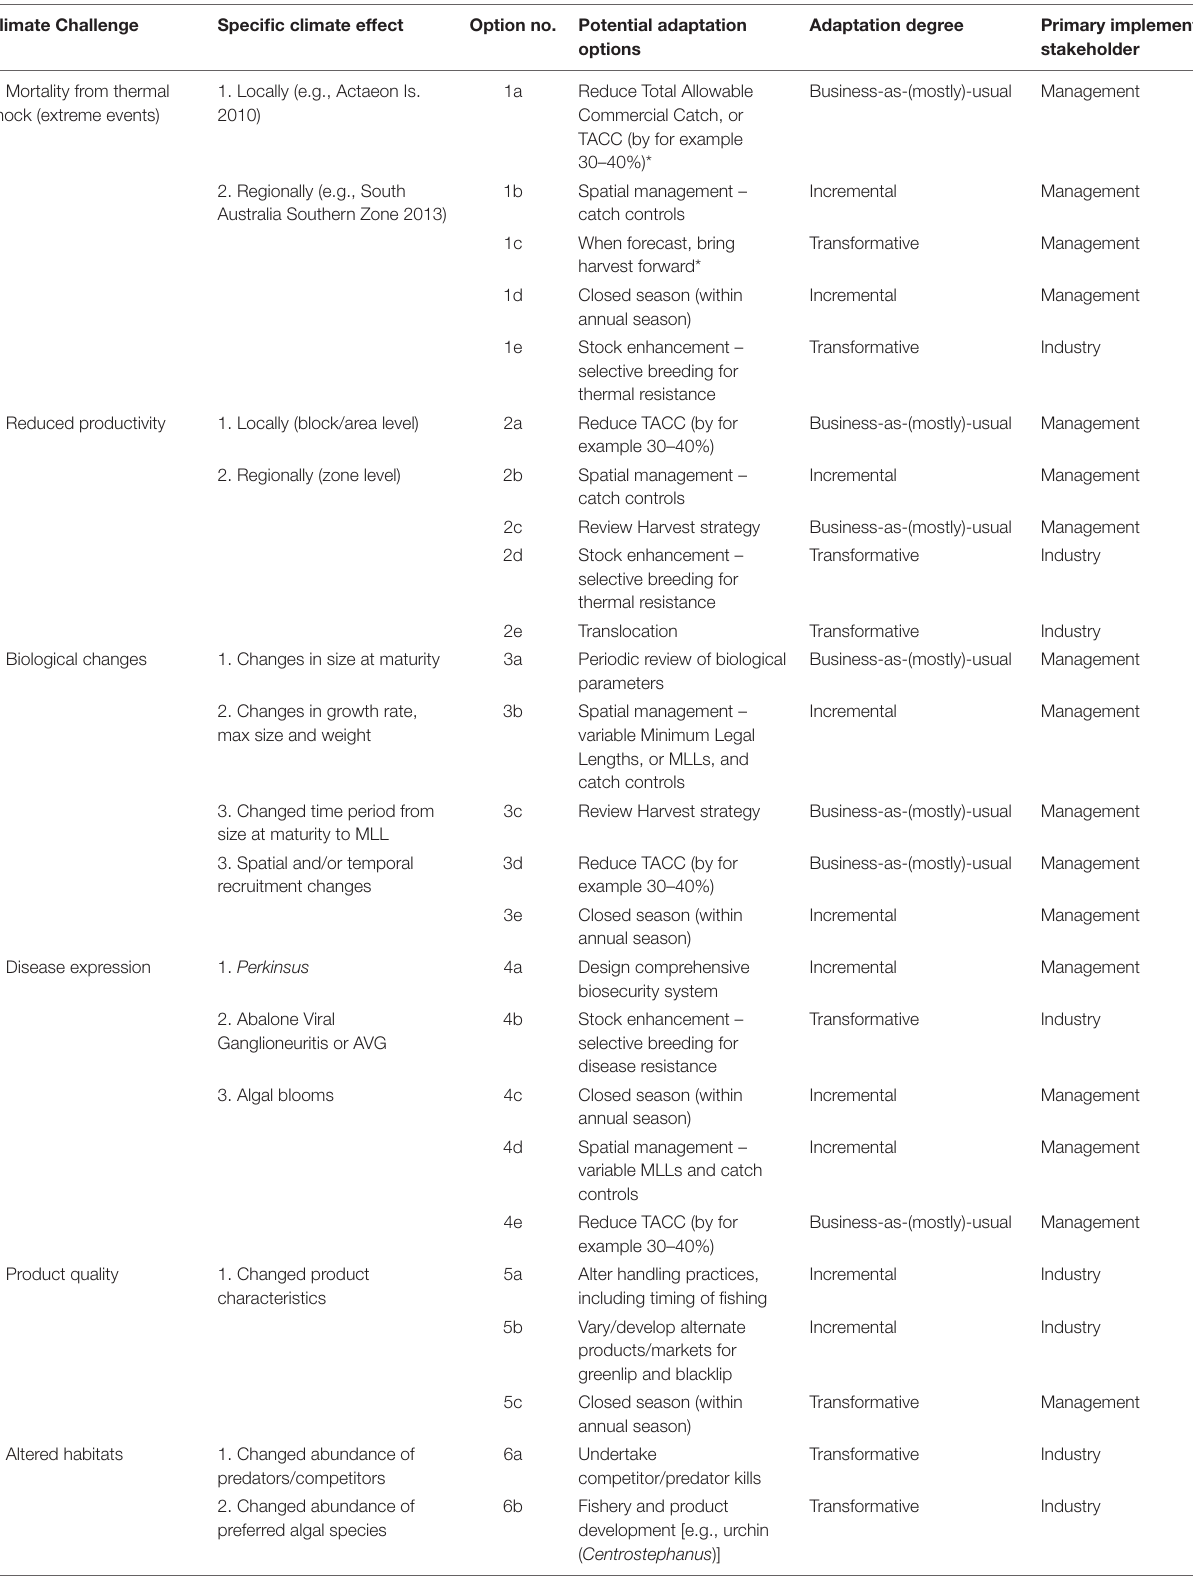
TABLE 3A | Summary characterization of adaptation options identified for